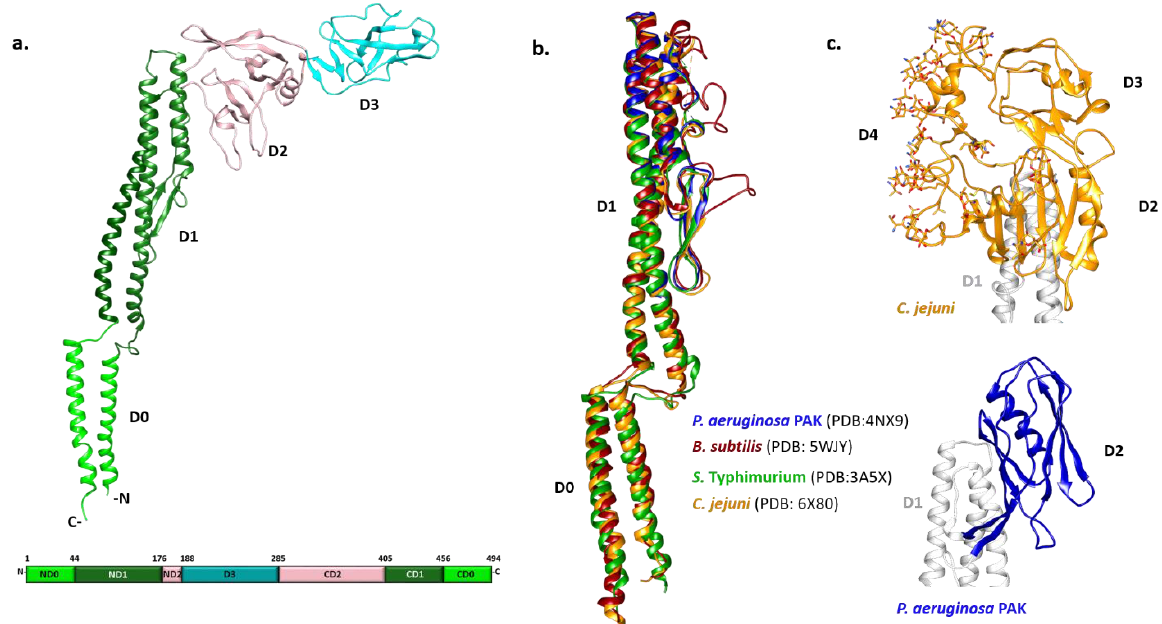
Figure 1. Structural characteristics of flagellins. ( a ) FliC monomer from S. Typhimurium with four distinct domain (PDB: